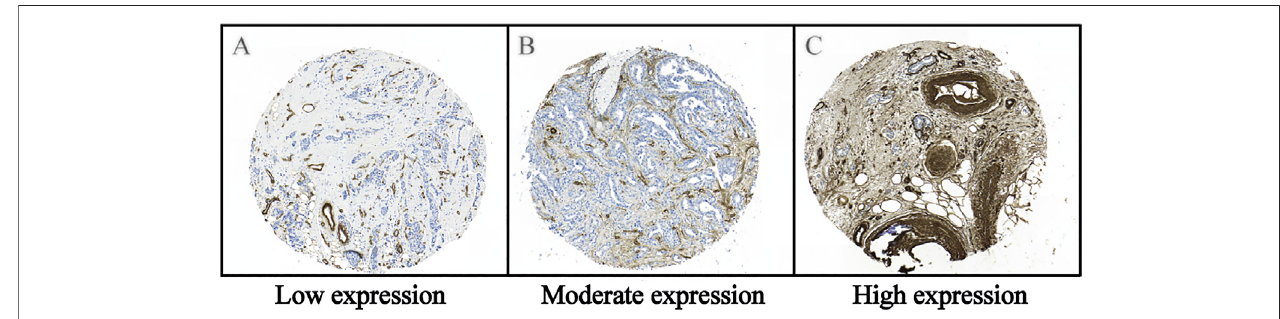
FIGURE 2 | Representative images of the immunohistochemical staining of type IV collagen in the tumor stroma of breast cancer tissue. (A) Low expression, (B) Moderate expression and (C) High expression of type IV collagen in the tumor stroma. Immunohistochemical staining for type IV collagen was performed in the